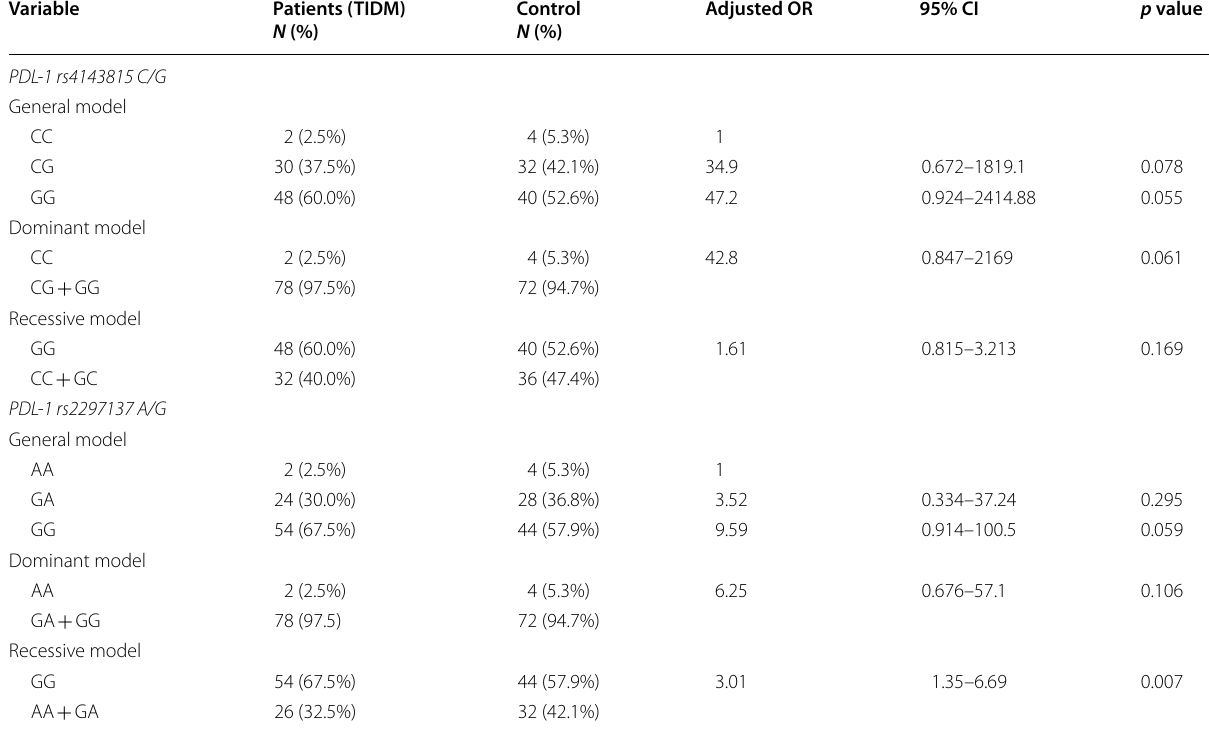
CI, confidence interval; OR, odds ratio; PDL-1, programmed death-ligand 1; SNPs, single nucleotide polymorphisms; OR, odds